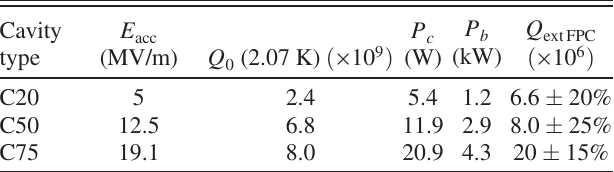
TABLE I. Nominal cavity performance parameters of cavities installed in original CEBAF